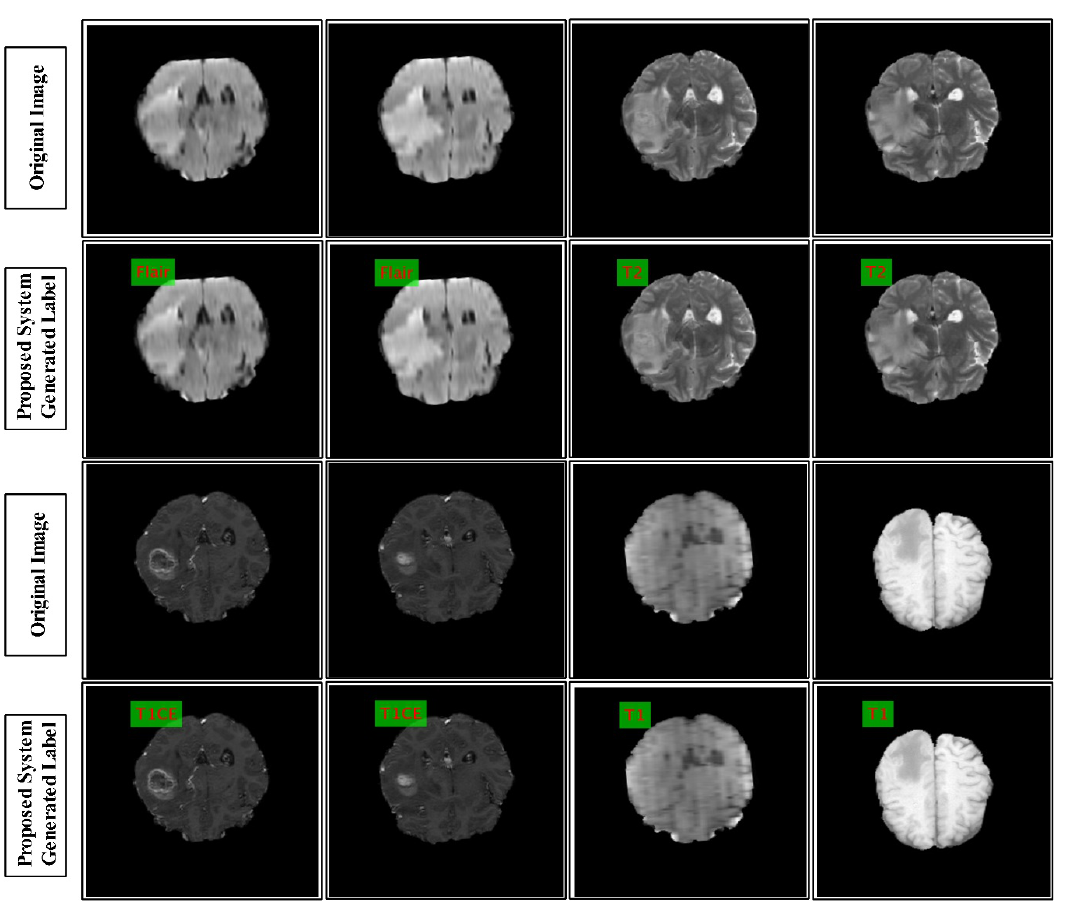
Figure 6. Labeled results generated by the proposed system. The label is shown in red on green square.